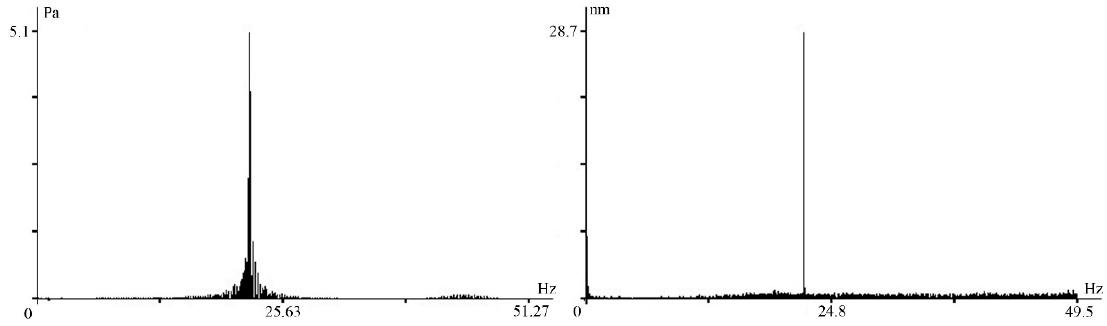
Figure 3. Sections of spectra of synchronous data from the hydrophone ( left ) and the laser strainmeter ( right ).